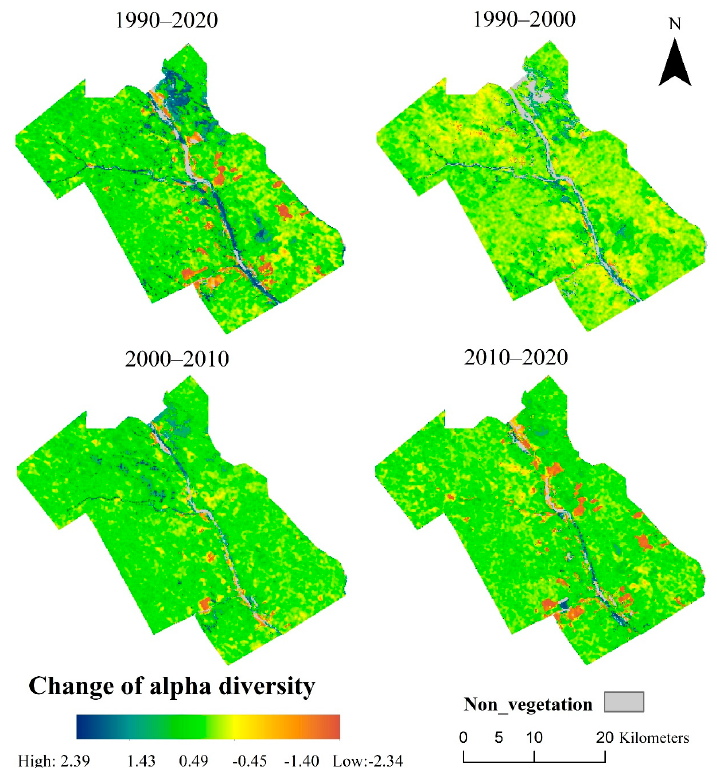
Figure 6. Changes in alpha diversity in the study area from 2000 to 2020.